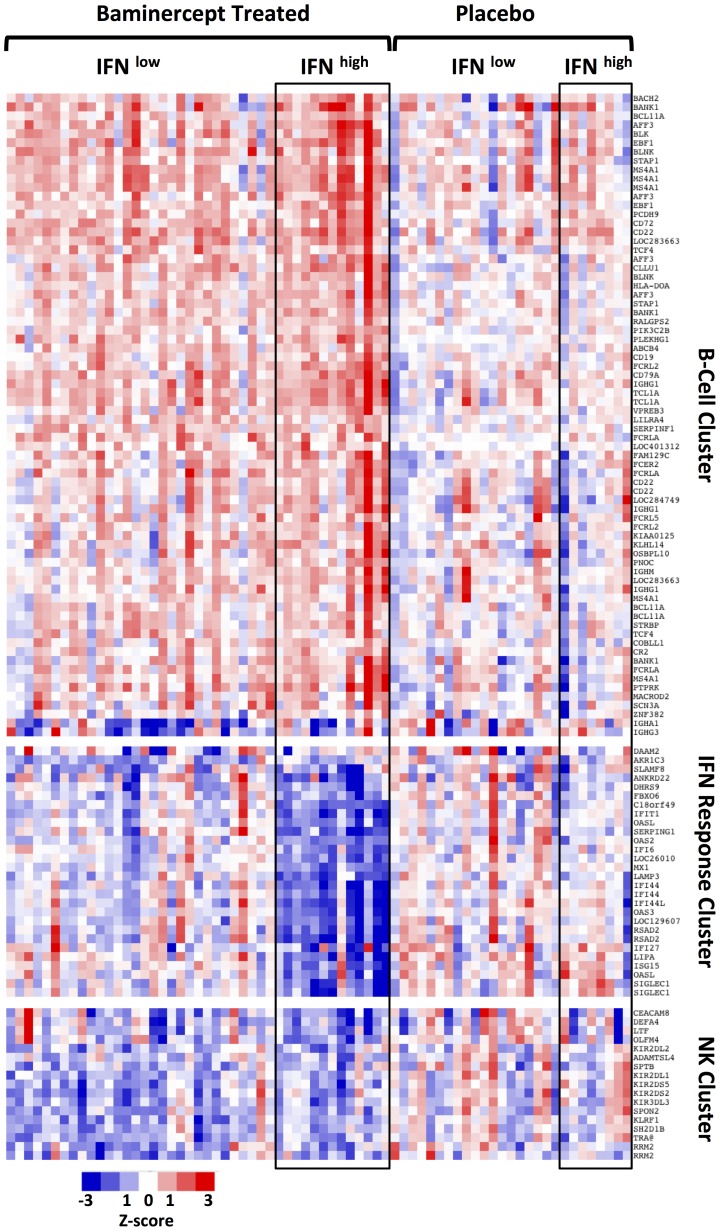
Baminercept induced changes in total blood RNA expression.Heat map showing the change in gene expression after 14 week of either placebo or baminercept treatment. Patients were forced into 4 groups based on treatment and baseline IFN signature. Each of the three gene clusters defined from initial unsupervised clustering are presented separately. The three clusters are characterized by genes associated with B cells, IFN response or NK cells, although some other genes are also present within each category. List only includes genes whose changes were significant (p<0.05), passed FDR and had greater than a 1.5 fold difference in a separate paired sample analysis.